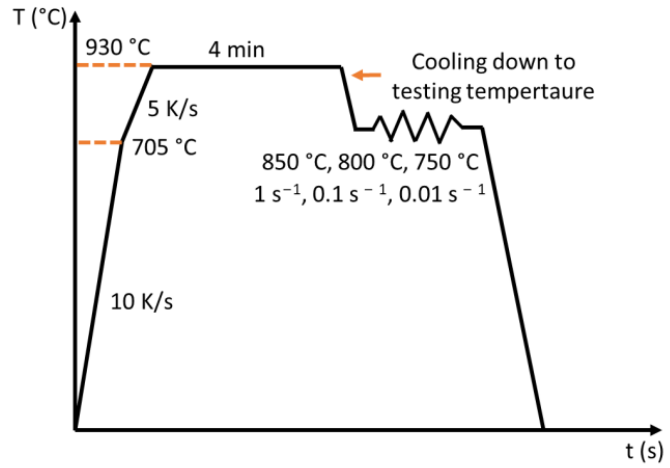
Figure 4. Scheme of thermo-mechanical cycles imposed on Gleeble system (adapted from ref. [10]). Force control mode was adopted during the physical simulation of the (i), (ii), (iii) and (vi) phases; instead, strain control mode was adopted during the (iv) phase.